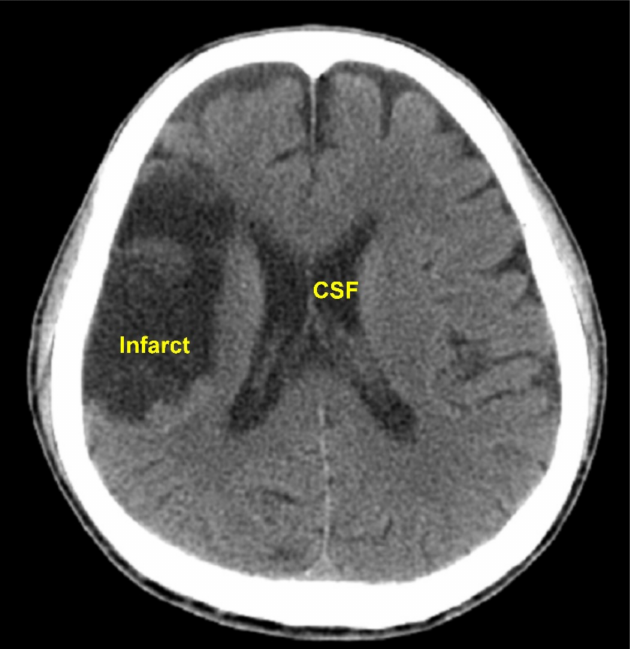
Figure 6. This CT image shows similar intensities of the CST and the infarct region. The CST could be falsely detected as infarcted if not eliminated before the infarct